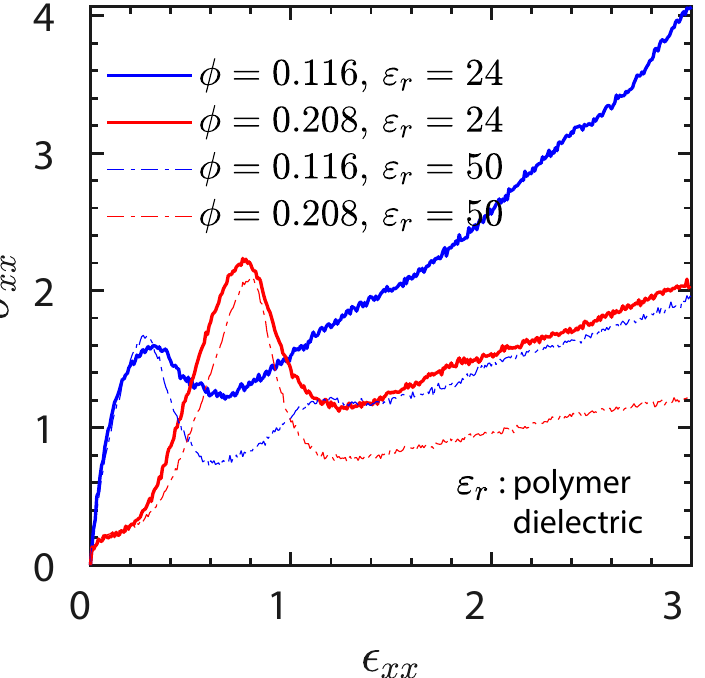
Figure 20. Stress–strain behavior of ionic modelled nanocomposites for different nanoparticle volume fractions and dielectric polymer medium constants, by NEMD. The stress component σ xx is reported in Lennard–Jones units. Reprinted with permission from Moghimikheirabadi et al.